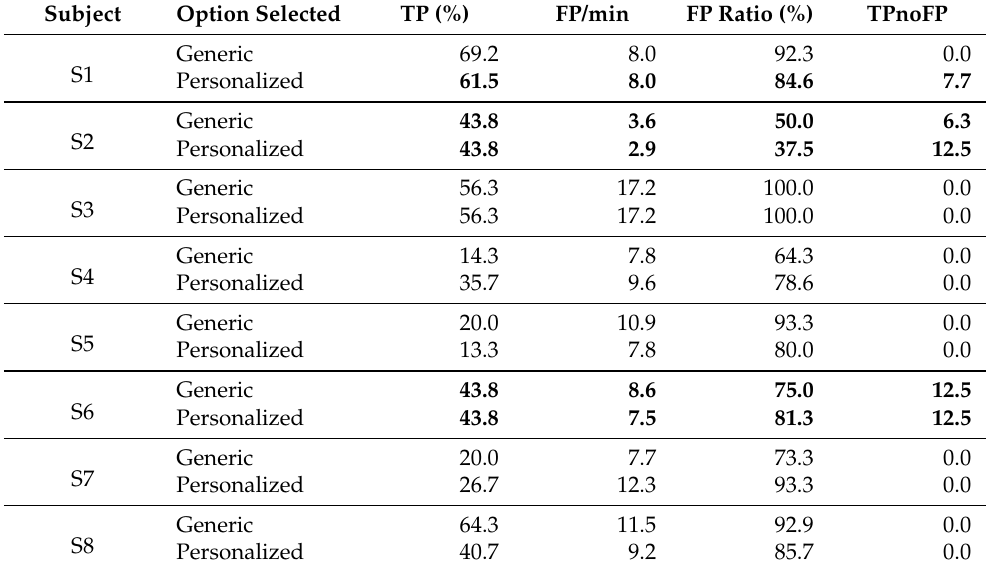
Table 7. Table with the results of the pseudo-online analysis: in the first row for the generic configu- ration and in the second row the customized one for each of the metrics. The configurations of the three users with repetitions with TP and without FP have ben highlighted in